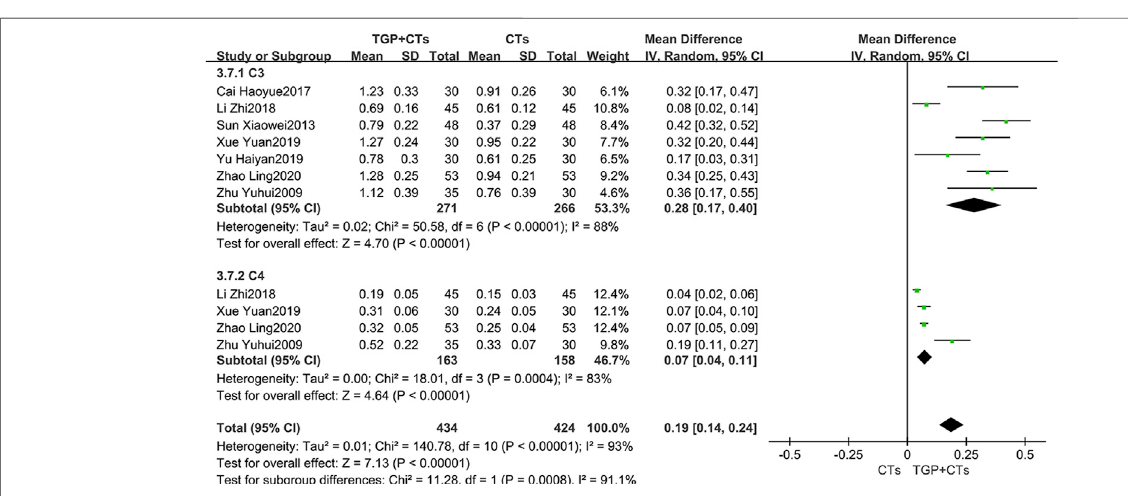
CTs showed a weighty decrease on the recurrence rate of SLE